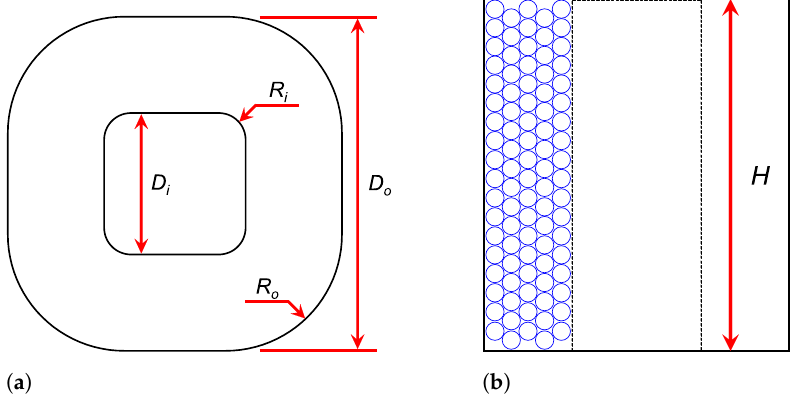
Figure 1. Round-corner square coil with key dimensions: ( a ) top view; ( b ) side view.